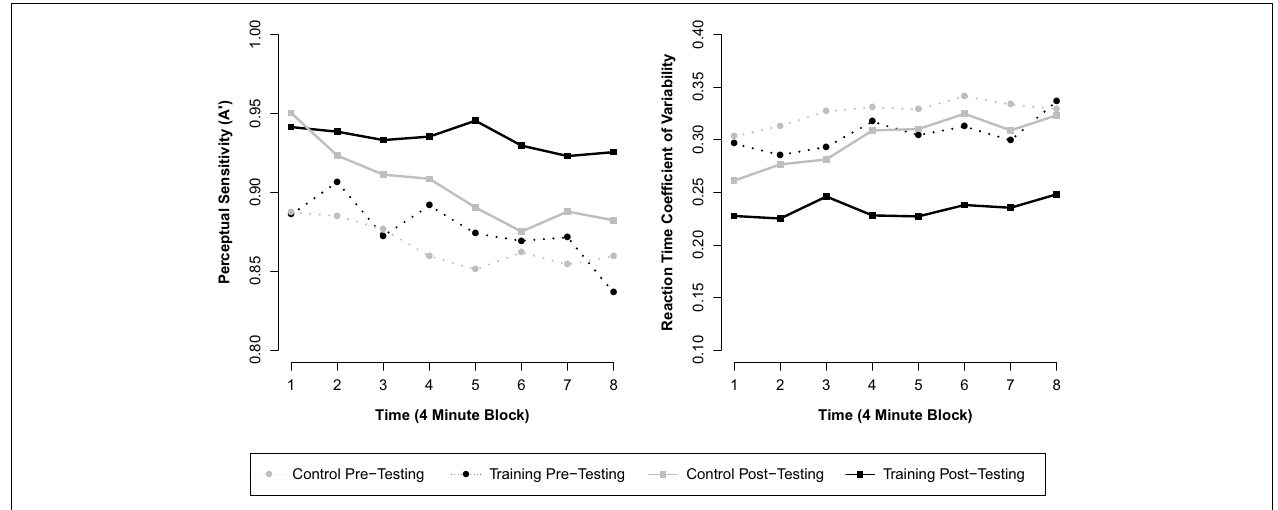
FIGURE 1 | Mean response inhibition accuracy and reaction time variability across eight contiguous 4-min blocks of the RIT by group and assessment.